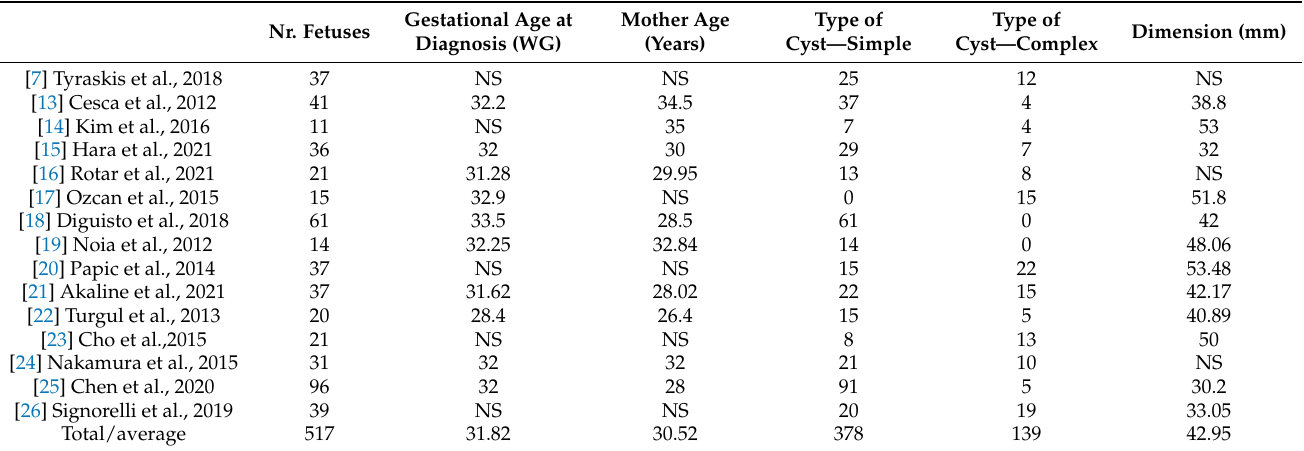
Table 1. General characteristics of studies.